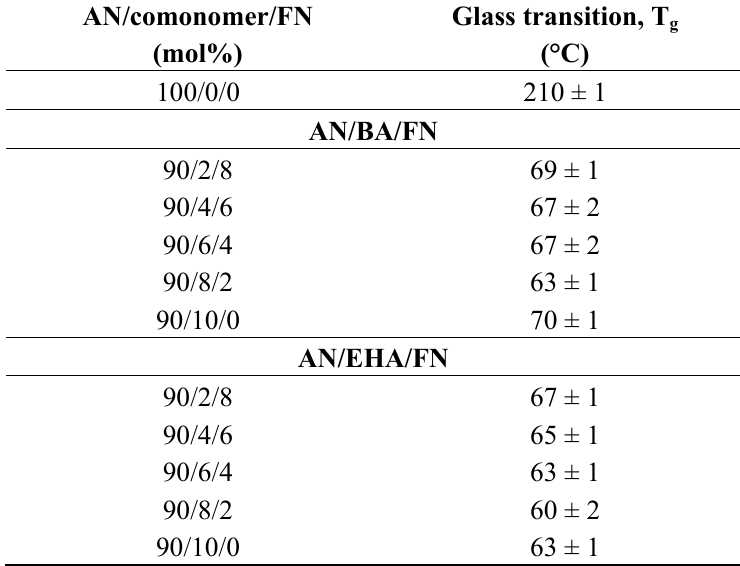
Table 2. Glass transition temperature of PAN homopolymer, copolymers, and terpolymers.